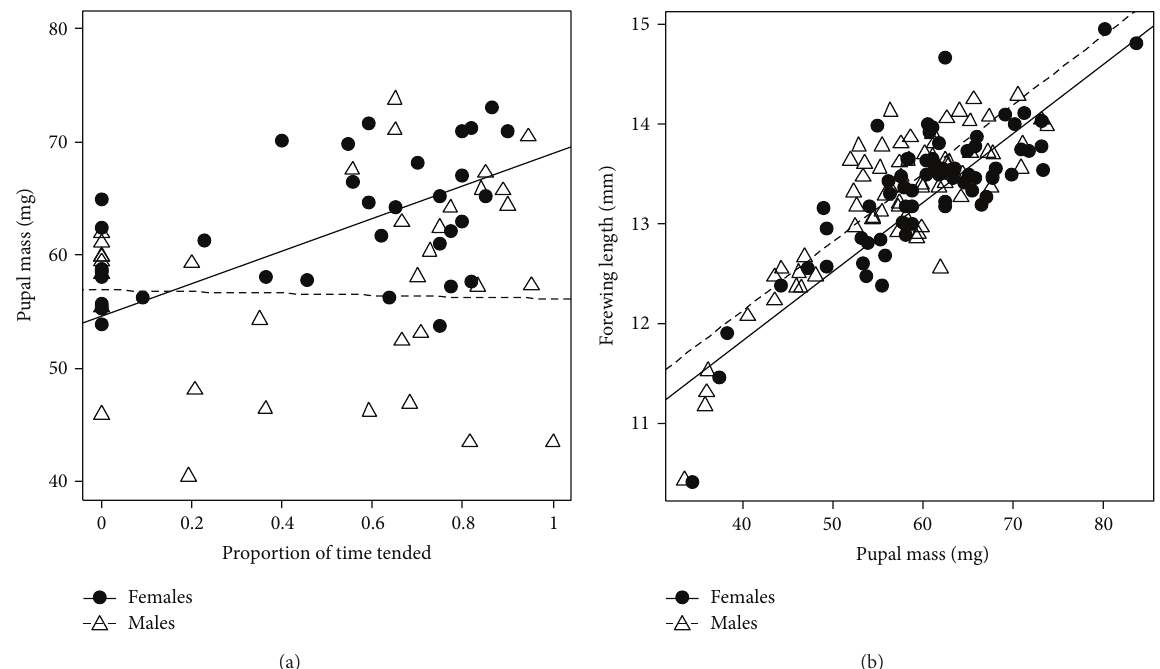
Figure 3: (a) Frequency of ant tending had sex-dependent effect on pupal mass, with female larvae pupating at a higher mass as tending increased whereas male larvae were unaffected by tending frequency. (b) Pupal mass and sex strongly predicted adult forewing chord length for Miami blue